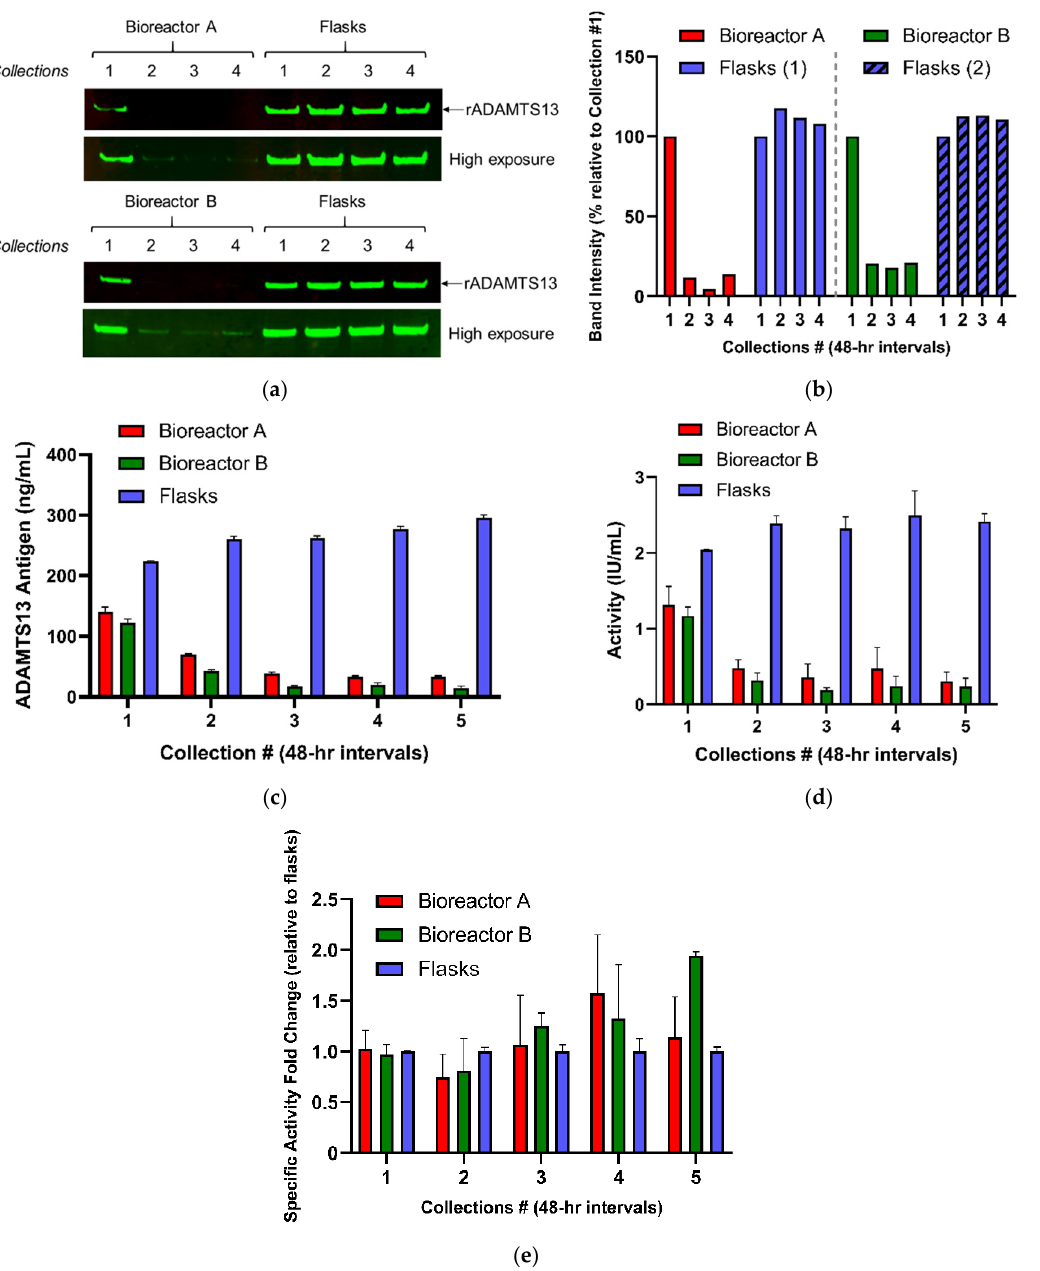
Figure 4. Comparison between bioreactor and flask cultivation systems for rADAMTS13 Flp-In stable HEK293 cells. ( a ) Western blot of V5-tagged rADAMTS13 from collections 1–4, with flask-derived collections shown on the right side adjacent to bioreactor A collections (top) and bioreactor B collections (bottom) for direct comparison; ( b ) Quantification of ADAMTS13 expression shown in western blots in panel A; two groups of flasks are shown for same-blot direct comparison ( c ) rADAMTS13 antigen levels of collections 1–5 from flasks and bioreactors A and B, as measured through ELISA assay; ( d ) Activity of rADAMTS13 in collections 1–5 from flasks and bioreactors A and B, as measured by FRETS-VWF73 activity assay; ( e ) Specific activity of rADAMTS13, as fold changes relative to flasks